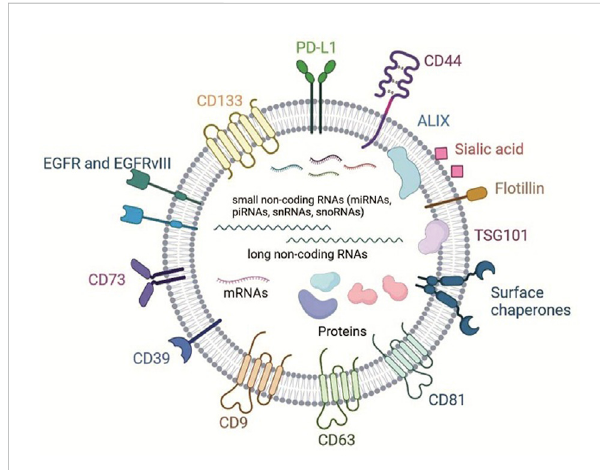
FIGURE 1 Scheme shows major protein membrane components and lipids of GBM-EVs and classes of cargo molecules (non-coding RNAs, mRNAs and cytosolic proteins, adopted with modi fi cations from Benecke et al., 2021; Naryzhny et al.